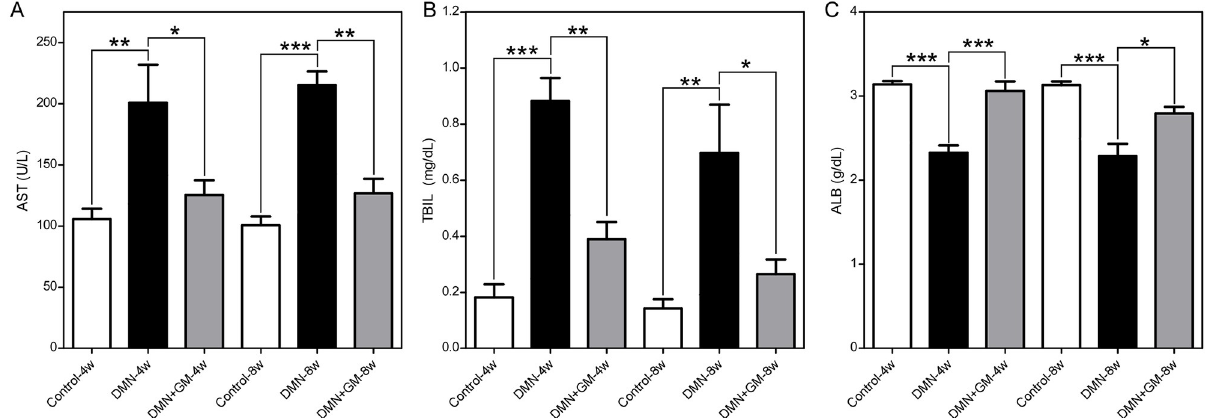
Fig 5. Effects of GM-CSF on DMN-induced hepatotoxicity. Blood samples were collected from venous and arterial blood vessels and heart chambers at 4 or 8 weeks after commencing DMN administration. Aspartate aminotransferase (AST), albumin (ALB), and total bilirubin (TBIL) in blood serum were determined spectrophotometrically. Changes in serum AST (U/L) ( A ), TBIL (mg/dL) ( B ), and ALB (g/dL) ( C ) in the DMN-4w and -8w and DMN +GM-4w and -8w groups. Results are expressed as means ± SEMs. The significances of differences between the control and DMN-treated groups and between DMN-treated groups and DMN+GM-CSF groups are expressed as ��� p � 0.001, �� p � 0.01, and � p � 0.05.